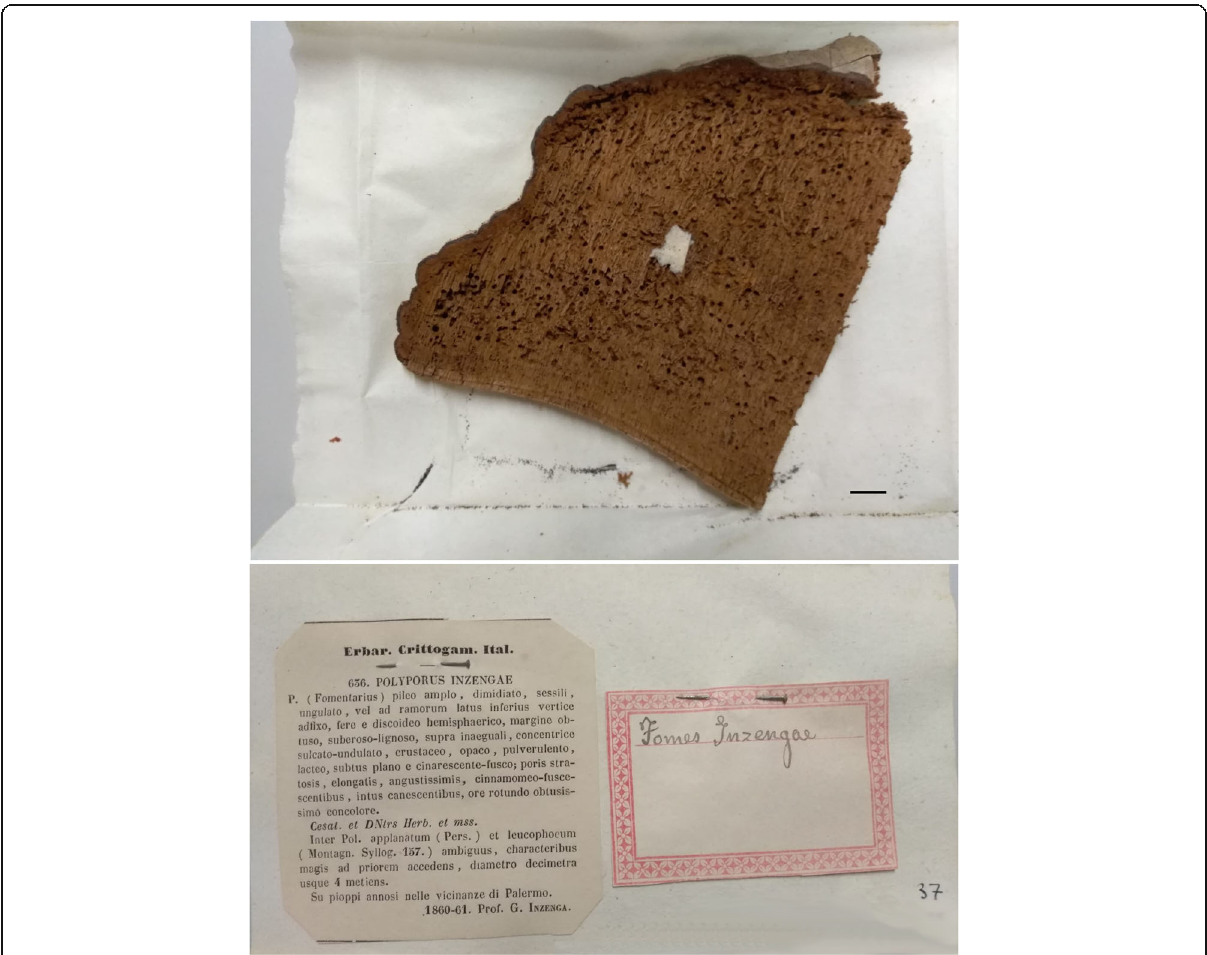
Fig. 11 Fomes fomentarius ( Bulliard tab. 491, fig. II C – F, 1791 – lectotype; as Boletus ungulatus ). Parts of the original plate including another fungal species as well as the respective legend (orginally labeled Fig. I) were digitally removed. Reprint based on an original of Bulliard deposited in the New York Botanical Garden, The LuEsther T Mertz Library. Scanned version: